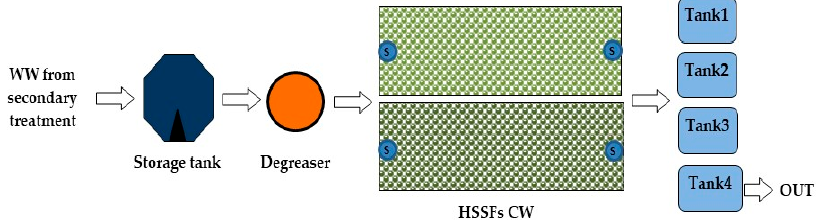
Figure 2. Layout of the WW treatment system based on HSSFs CW.